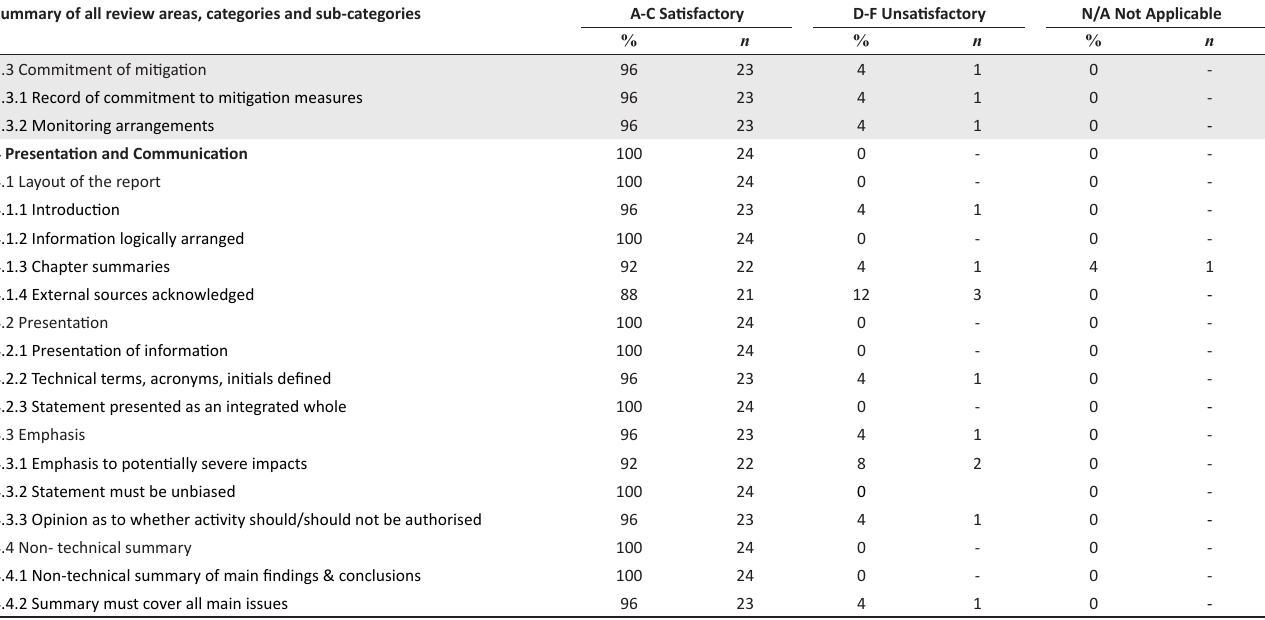
TABLE 3 (Continues...): Summary of results: Overall grades, review areas and review categories ( n = 24). Summary of all review areas, categories and